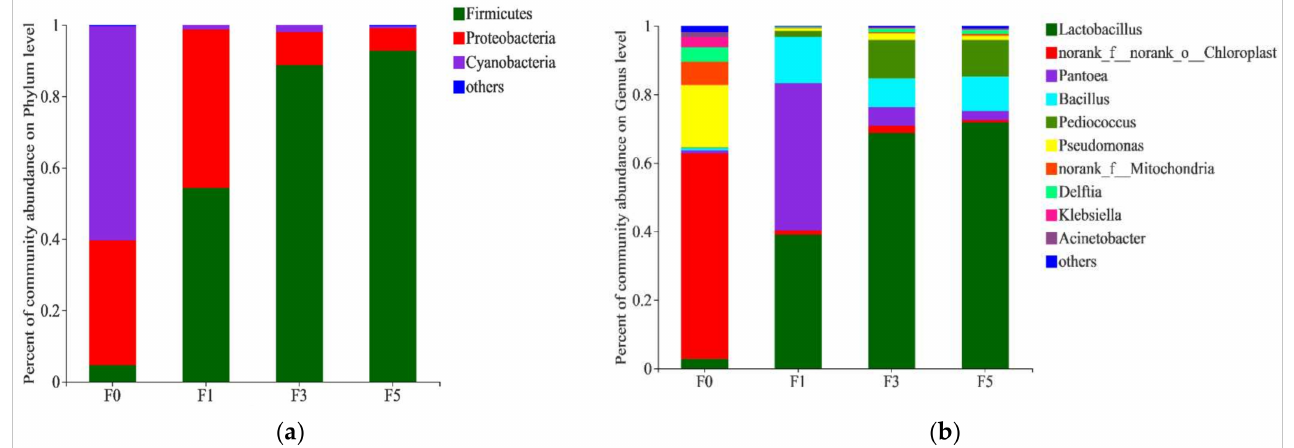
Figure 2. Relative abundance, following fermentation of the tea residue mixture treatment groups F0, F1, F3, and F5; bacterial communities at the phylum level ( a ) and genus level ( b ). The bacterial communities were mainly correlated with pH and ASP, ADF, and NDF content (Figure 3). Enterococcus , Pediococcus , and Lactobacillus were the main or- ganisms that affected these indicators. Enterococcus was positively correlated with pH, ADF, and NDF, and negatively correlated with ASP ( p < 0.05). Pediococcus and Lactobacillus were positively correlated with ASP but negatively correlated with pH, ADF, and NDF. Methylobacterium-Methylorubrum and Sphingomonas were positively correlated with NDF. However, Methylobacterium-Methylorubrum had a negative effect on EE and Sphingomonas had a negative effect on ASP.